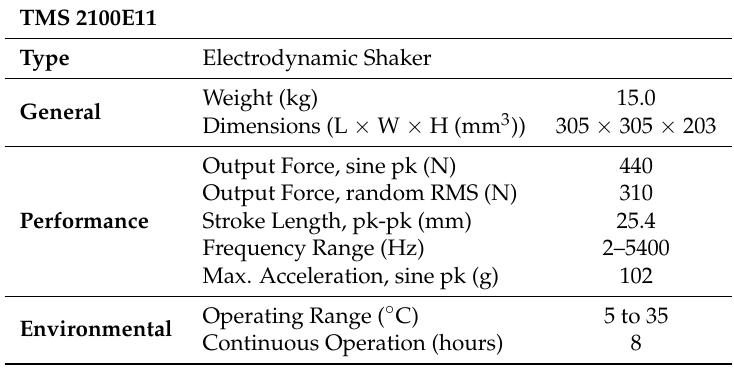
Table A3. Technical specifications of the electrodynamic shaker TMS